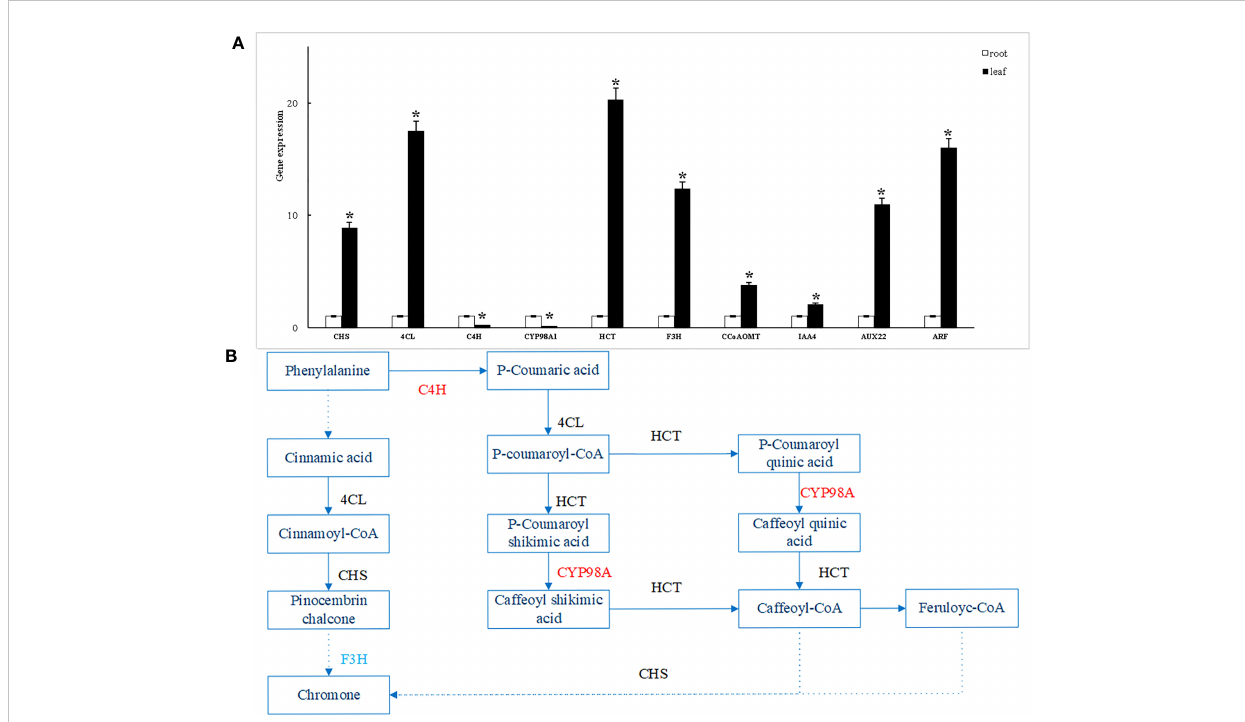
FIGURE 7 RT-qPCR validation of differentially expressed genes (A) and biosynthesis pathway of fl avonoids in S. divaricata (B) . *: Indicates signi fi cant difference (P<0.05).